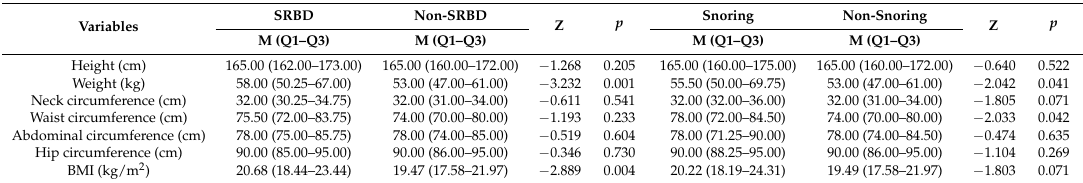
Table 2. Anthropometric parameters of adolescents.